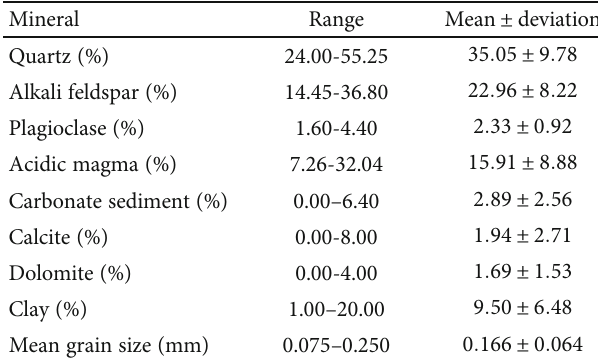
Table 8: Descriptive statistics of the main mineral compositions of